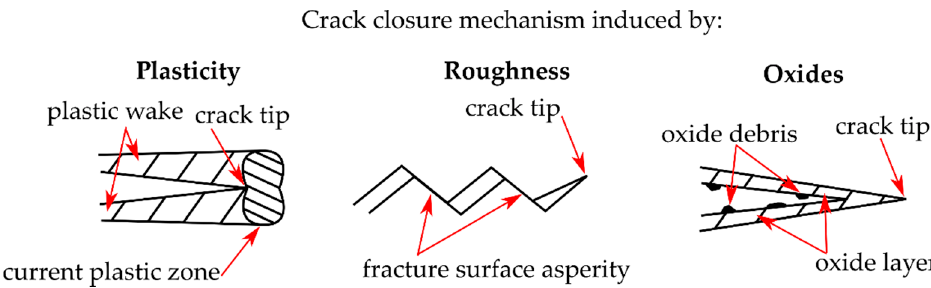
Figure 1. Mechanisms of crack closure due to plastic deformation in the crack wake, fracture surfaces roughness and oxide debris produced on fracture surfaces.